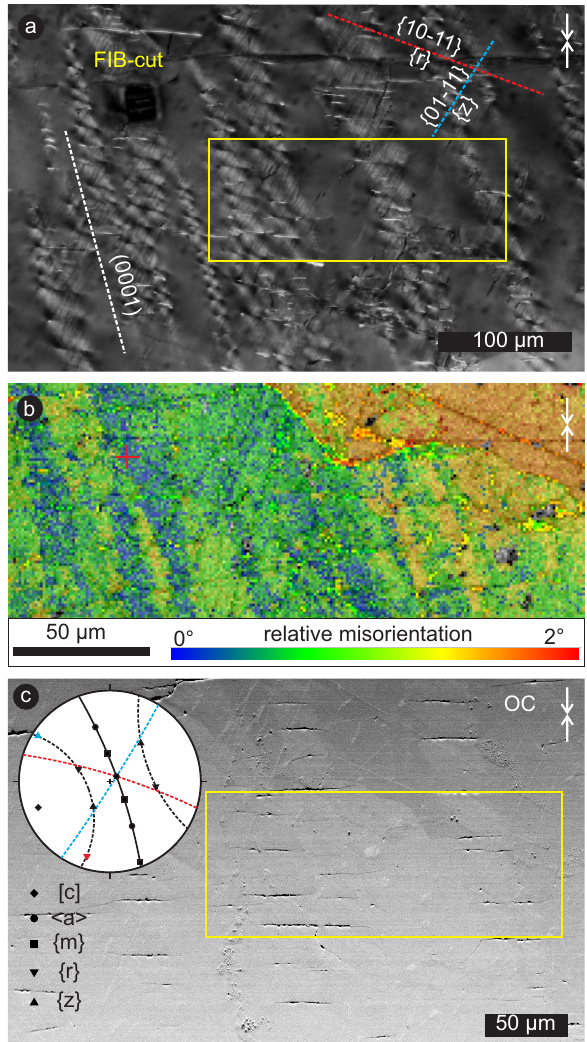
Fig. 3. Quartz microfabric after “kick” experiment CR-1-3 per- formed at 400 ◦ C, 2GPa confining pressure, and strain rate of 10 − 4 s − 1 . The shortening direction is vertical in all images, in- dicated by white arrows. (a) Polarized light micrograph showing slightly misoriented domains parallel (0001), containing arrays of microcracks and lamellae parallel to { r } and { z } rhombohedral planes. Location of EBSD map displayed in (b) is indicated by yel- low rectangle. (b) EBSD map showing domains with misorientation relative to reference point (red cross); colours indicate misorienta- tion, displayed as overlay on band contrast image in grey shades; non-coloured areas are not indexed. (c) Orientation contrast image of area shown in (a) and pole figure (lower hemisphere, equal an- gle) displaying crystallographic orientation. Location of the EBSD map shown in (b) is indicated by yellow